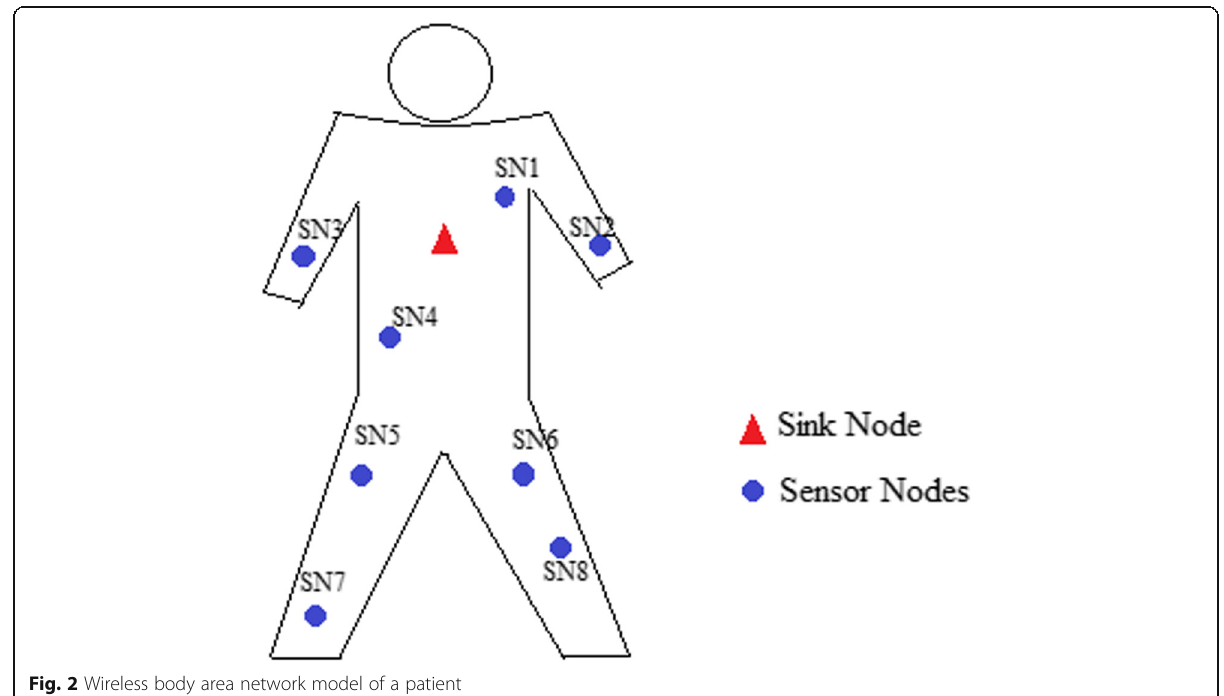
Fig. 2 Wireless body area network model of a patient